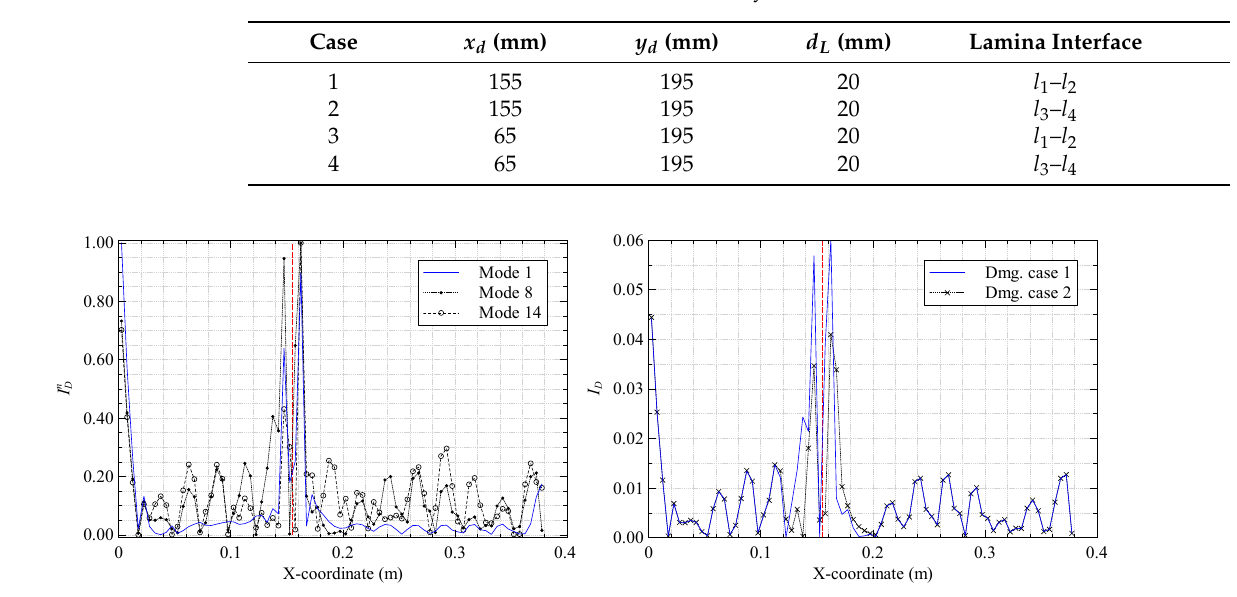
Figure 7. Damage index plots along y = 197.5 mm for ( left ) damage case 1 and ( right ) mode 8 (the vertical red line indicates the damage site).